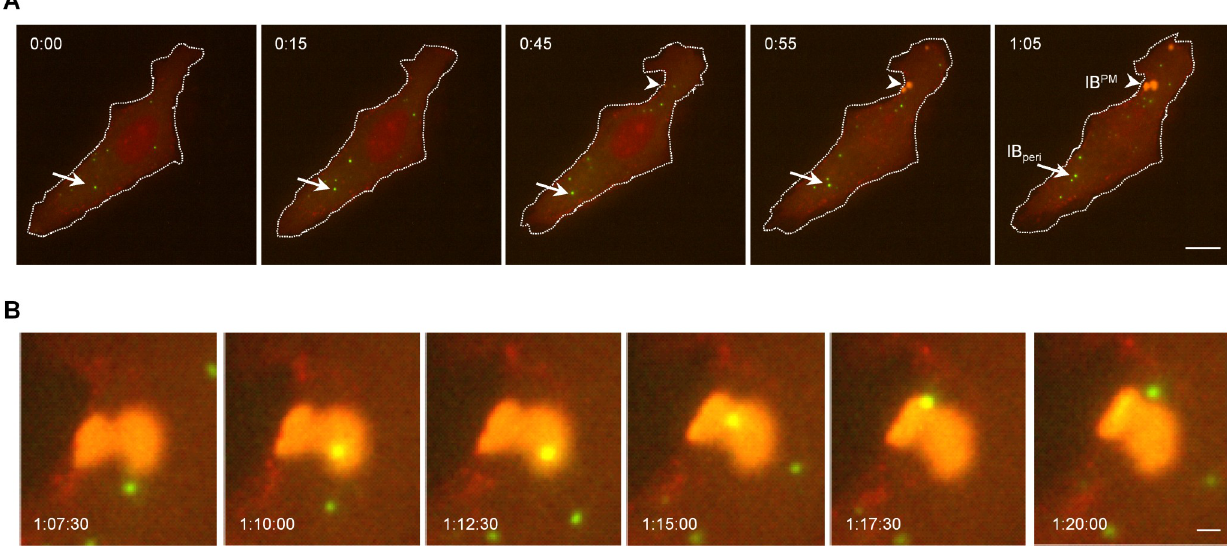
Fig 4. Formation of NiV IB peri and IB PM monitored by live cell imaging. To follow IB formation in the presence of M over time, Vero76 cells were cotransfected with NiV N and NiV P eGFP together with mCherry NiV M and untagged NiV M (see Materials and Methods).At 14 h p.t., the live cell time-lapse experiments were started. Images were recorded with a Nikon TE2000 microscope. IBs (green) and M proteins (red) were detected via the P eGFP or the mCherry M autofluorescence, respectively. Pictures were taken every 50 sec and processed with Nikon NIS-Elements Microscope Imaging Software. (A) Merged images of the whole cell at different time points are shown. The plasma membrane is indicated by the dotted line. Arrows indicate M-negativeIBs in the cytoplasm (green). Arrowheadsindicate the site where M-positive IBs are formed at the plasma membrane (yellow, IB PM ). Scale bar, 10 μ m. (B) Magnification of an IB PM (indicated with an arrowhead in panel a). Scale bar, 1 μ m.The full-length video is provided as S1 Movie.For comparison, S2 Movie shows IB formation in the absence of the M protein.